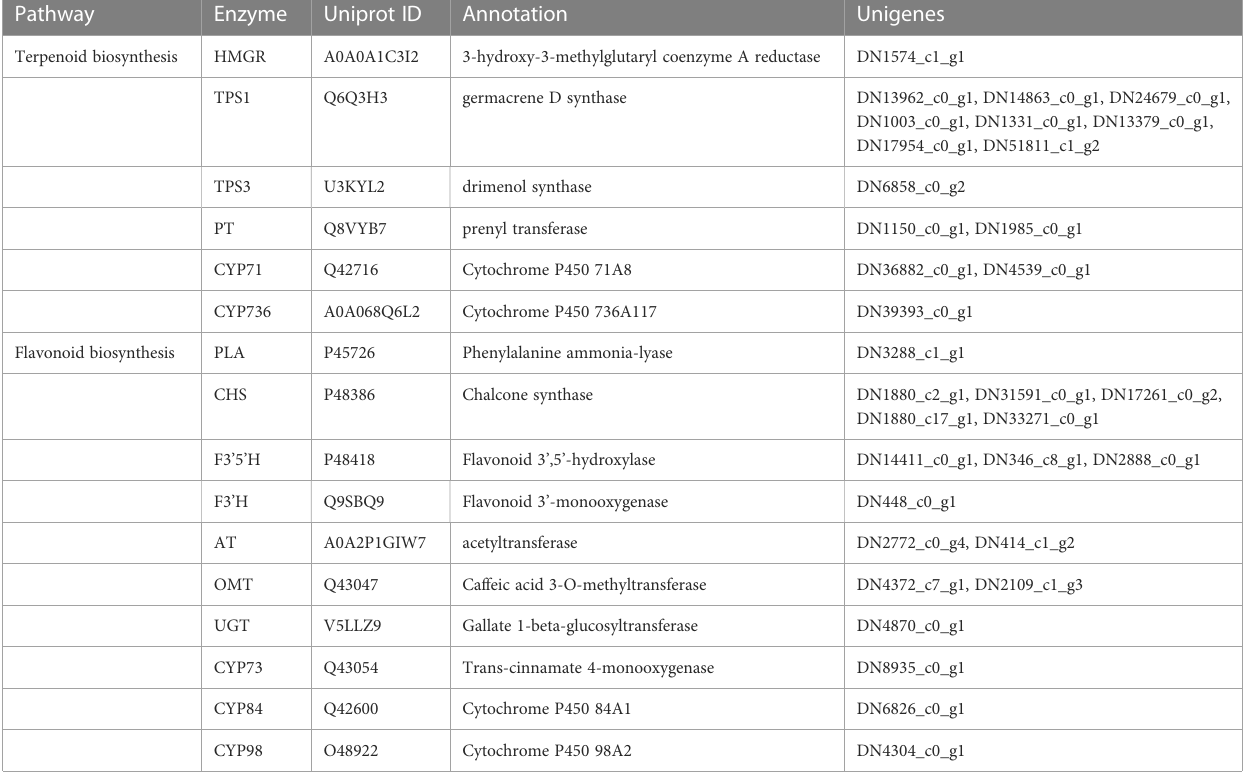
TABLE 2 Information of the candidate genes associated with elevation, involved in the biosynthetic pathway of late fl ower bud and early leaf buds. Pathway Enzyme Uniprot ID Annotation Unigenes Terpenoid biosynthesis